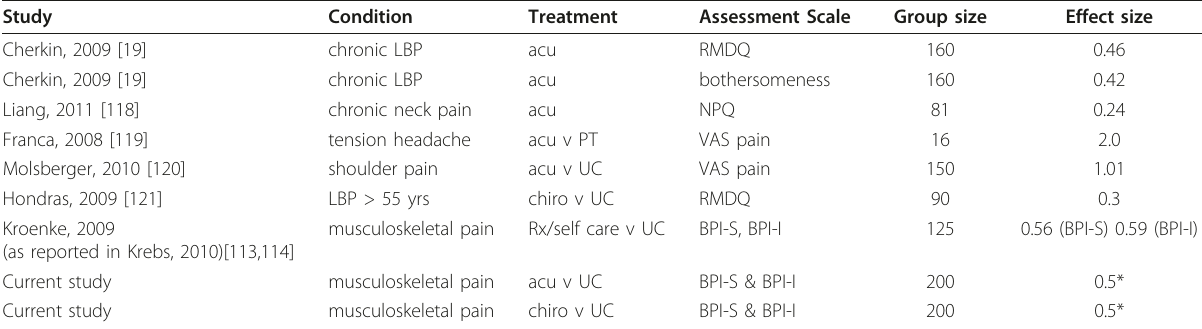
Table 6 Sample and Effect Sizes for Related and Current Study Study